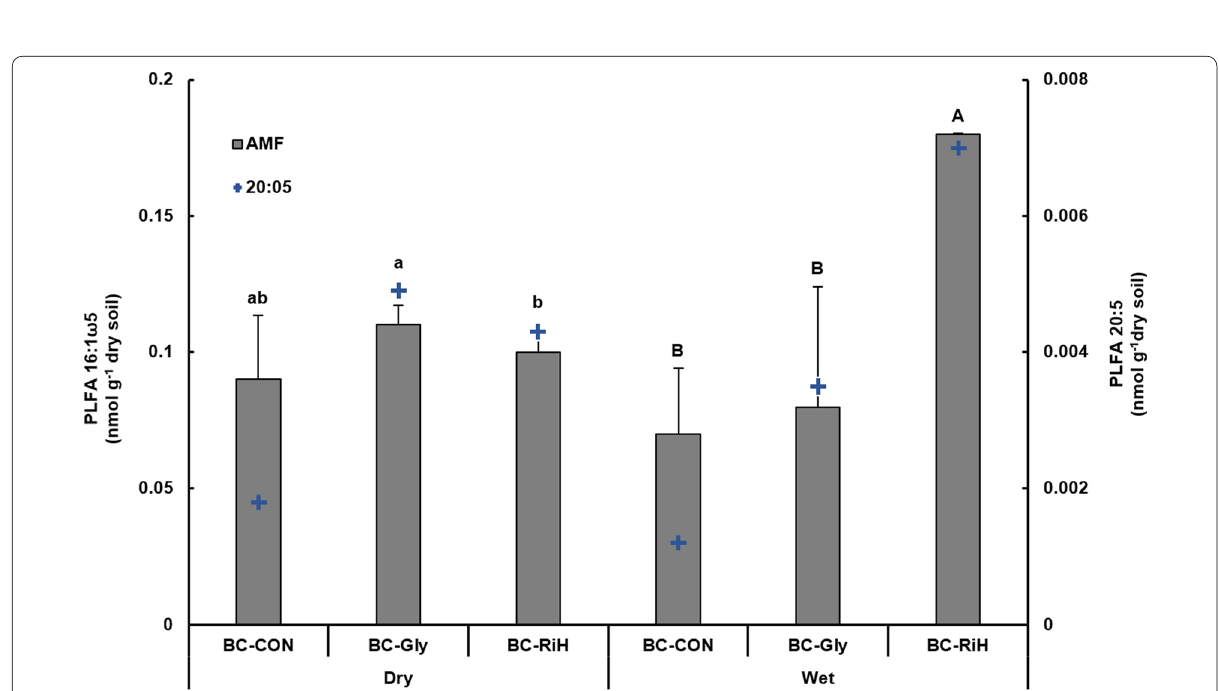
Fig. 5 Effect of biochar on AMF PLFAs 16:1ω5 (Bars) and 20:5 (Marker point) under dry and wet moisture conditions in the hyphal zone (bottom compartment). Different lowercase letters and capital letters indicate significantly different concentrations (nmol g − 1 dry soil) of PLFA 16:1ω5 (One-way ANOVA and LSD; p 0.05) between the biochar treatments under dry and wet moisture conditions, respectively, Vertical bars represent ≤ standard errors of the means (n =